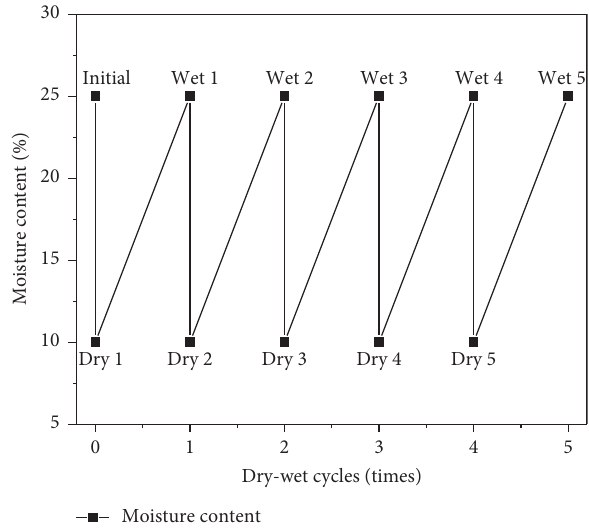
Figure 2: Schematic of the dry-wet cycle